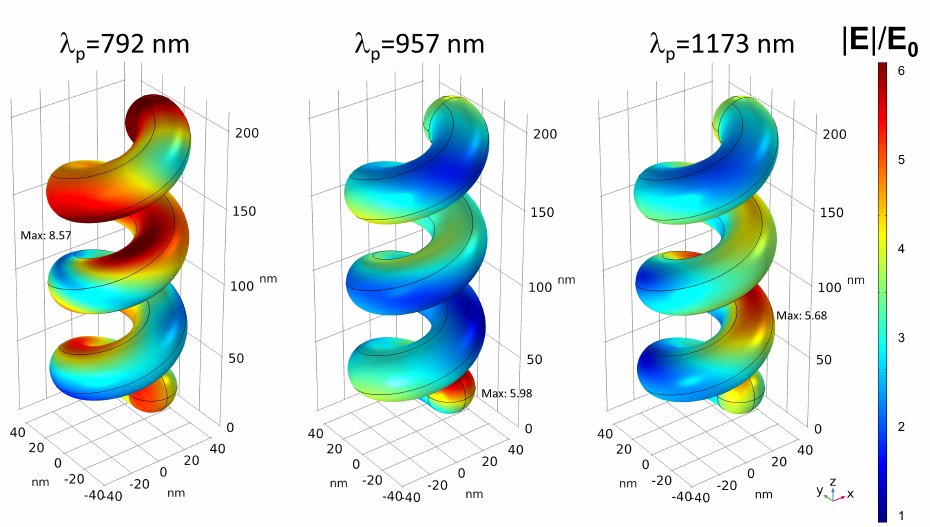
Figure 4. Electric field enhancement on the helix surface at the three λ p : 792 nm, 957 nm, and 1173 nm. The intrinsic chiral nature of the plasmonic metasurface considered allowed using dichroic signals for sensing applications. In this case, it was possible to exploit the absence of the intrinsic mirror symmetry of the structure and the corresponding difference in its interaction with circularly polarized light. For this reason, the same numerical model was modified to have both Left-handed Circular Polarized (LCP) and Right-handed Circular Polarized (RCP) light affecting the structure, with an incidence angle equal to 50 ◦ . In the Materials and Methods section, we described how it was possible to propagate Circular Polarized waves in Comsol Multiphysics. In Figure 5a,b, it is possible to see the absorbance and transmittance curves for the plasmonic metasurface characterized by an in-plane